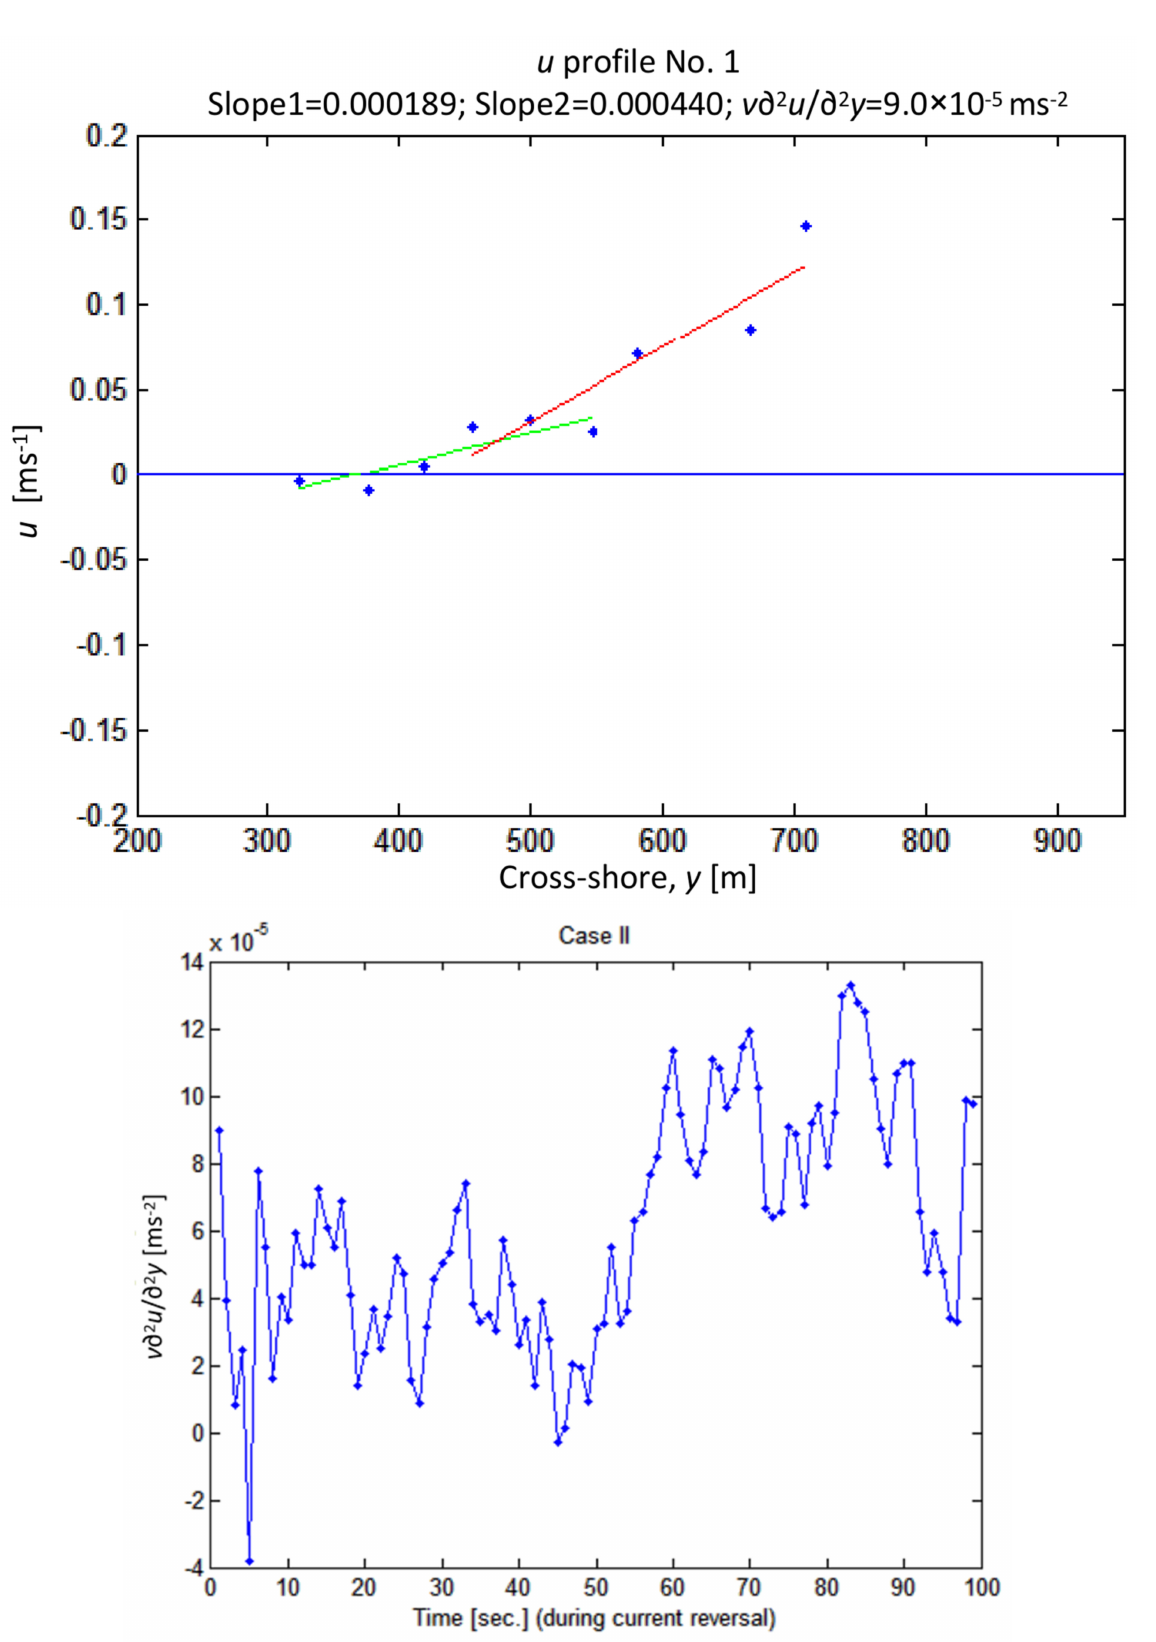
Figure A3. Calculation example of the horizontal dispersion term based on the drifter data of Case II (upper panel). Time series of the horizontal dispersion term of Case II (lower